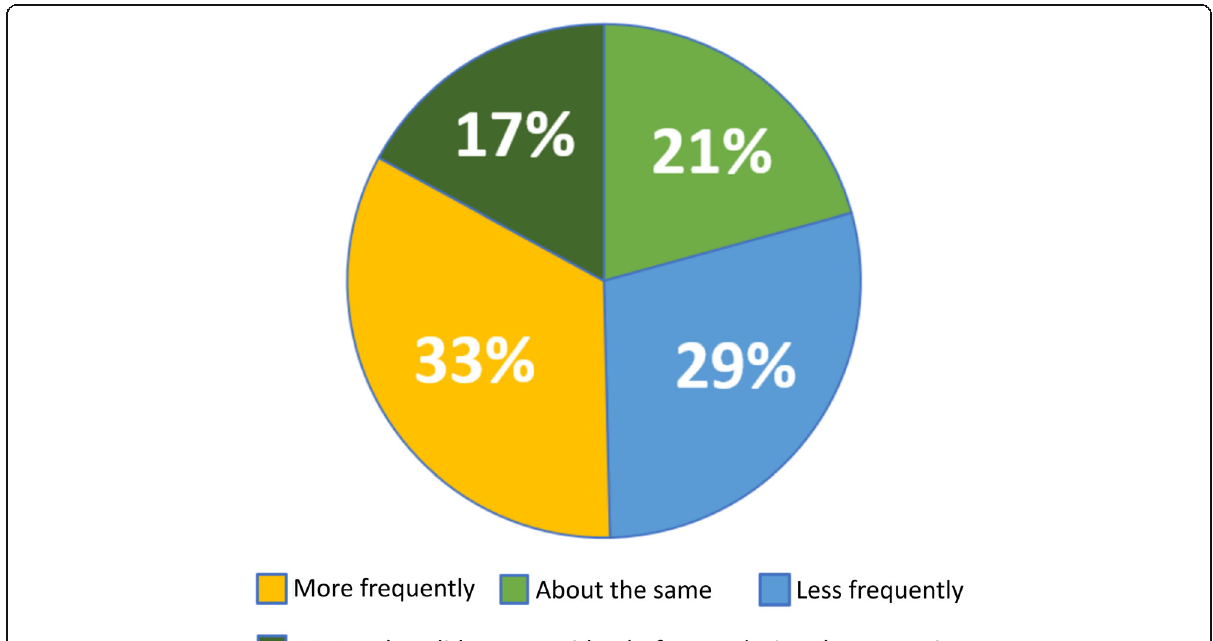
Fig. 10 Comparison of teacher use of video before and during pandemic